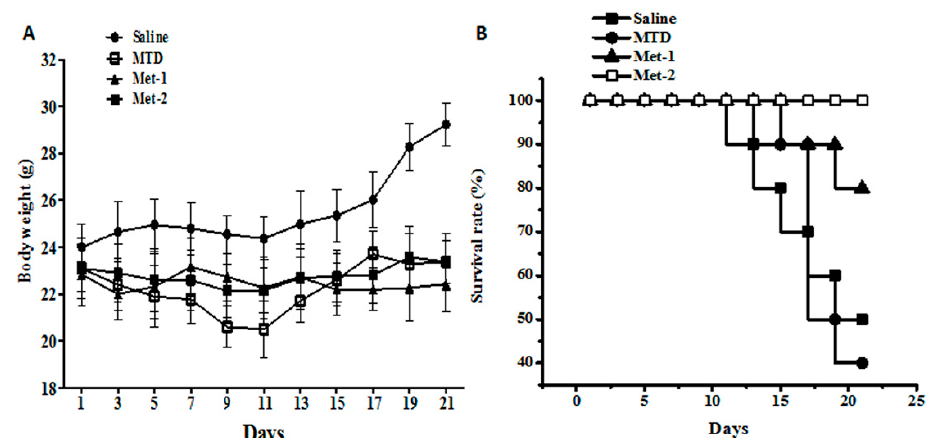
Figure 1. Toxicity evaluation of cyclophosphamide in the LLC model. ( A ) The body weight of mice from each group at the end of the observation period; ( B ) The survival rate of mice from each group at the end of the observation period. C57BL mice were injected with 10 6 cells in the right flank; after four days, cyclophosphamide at di ff erent schedules was given for three weeks. Body weight was measured every other day using a weight scale; the mice were killed on day 22. MTD: 3 doses of 150 mg / kg each, for the first week only; Met-1: 170 mg / kg every 6 days; Met-2: 25 mg / kg every other day.